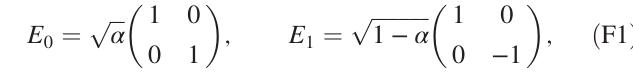
FIG. 13. Control sequence data. Measured amplitudes of selected two-qubit Pauli vector components as a function of qubit preparation. In experiments identical to those in Fig. 3, the two qubits were prepared in the desired initial state, but no flying photons were generated. Joint tomography of the final two-qubit state was performed. (a) With Bob always initialized in ð 1 = Alice was prepared in the variable state cos ð θ = 2 Þj g i þ sin ð θ = 2 Þj e i . (b) With Alice always initialized in ð 1 = ffiffiffi p 2 prepared in the variable state ð 1 = Þðj g i þ e i ϕ j e iÞ . In both cases, data (points) and fits (lines) confirm that no two-qubit entanglement is observed. This is most directly indicated by h ZZ i ¼ 0 , unlike Fig.